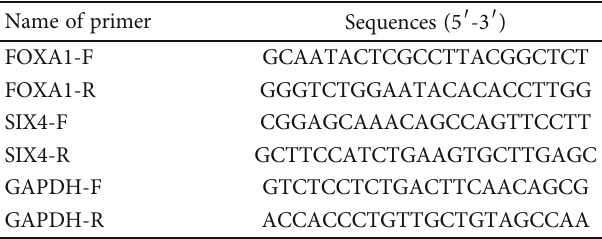
Table 1: Primer sequences. Name of primer Sequences (5 ′ -3 ′